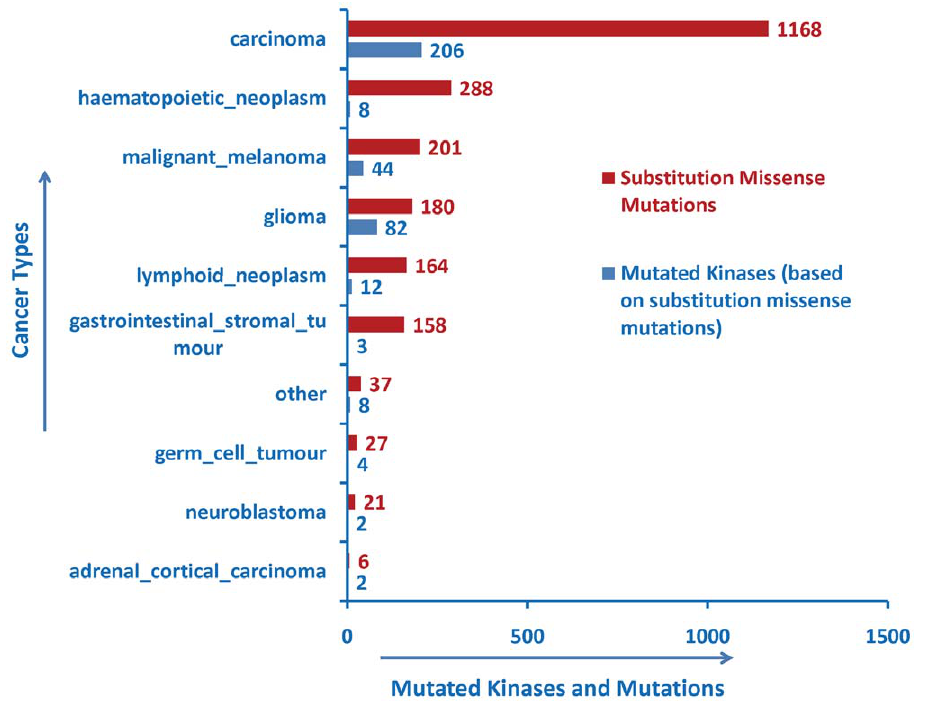
Figure 6. Counts of substitution missense mutations (at least 4) implicated in different types of cancer, and counts of protein kinases having missense mutations implicated in different cancer types. As mentioned in the text, haematopoietic_neoplasm has 288 mutations in 8 kinases, while glioma has 180 mutations spread over 82 kinases. The SPARQL query to generate this figure can be directly viewed and excuted from the ProKinO browser by selecting ‘‘Query 5a’’ and ‘‘Query 5b’’ under the ‘‘Example queries’’ tab in the main page.